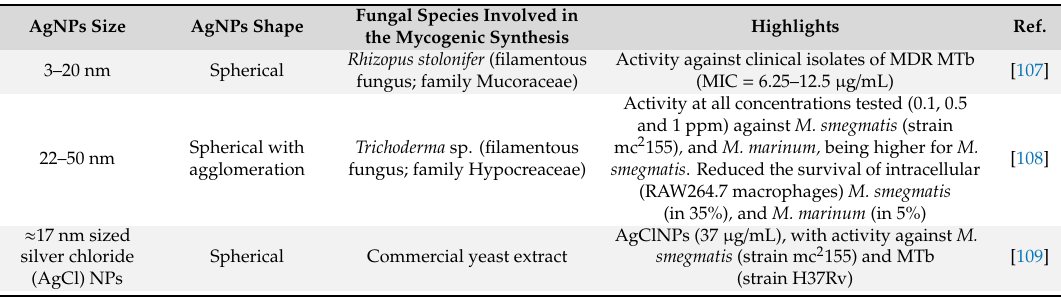
Table 4. Mycogenic AgNPs with reported activity against